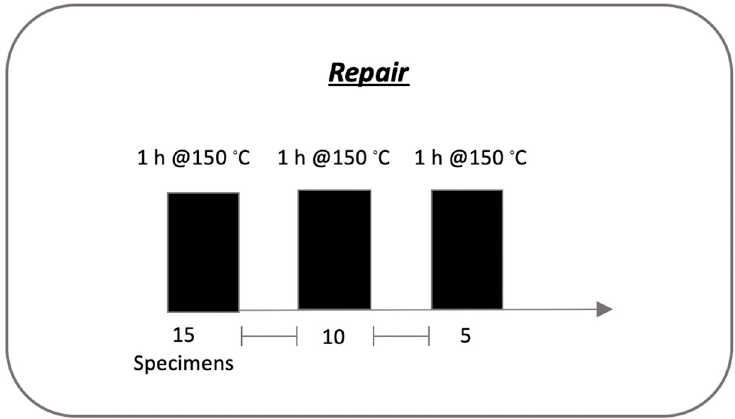
Figure 4. Testing plan for the repair